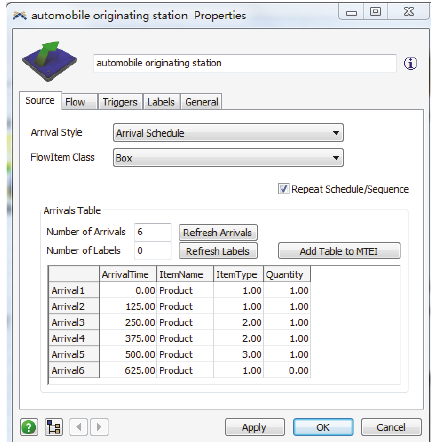
Figure 8: Production tack time and interval time setting.